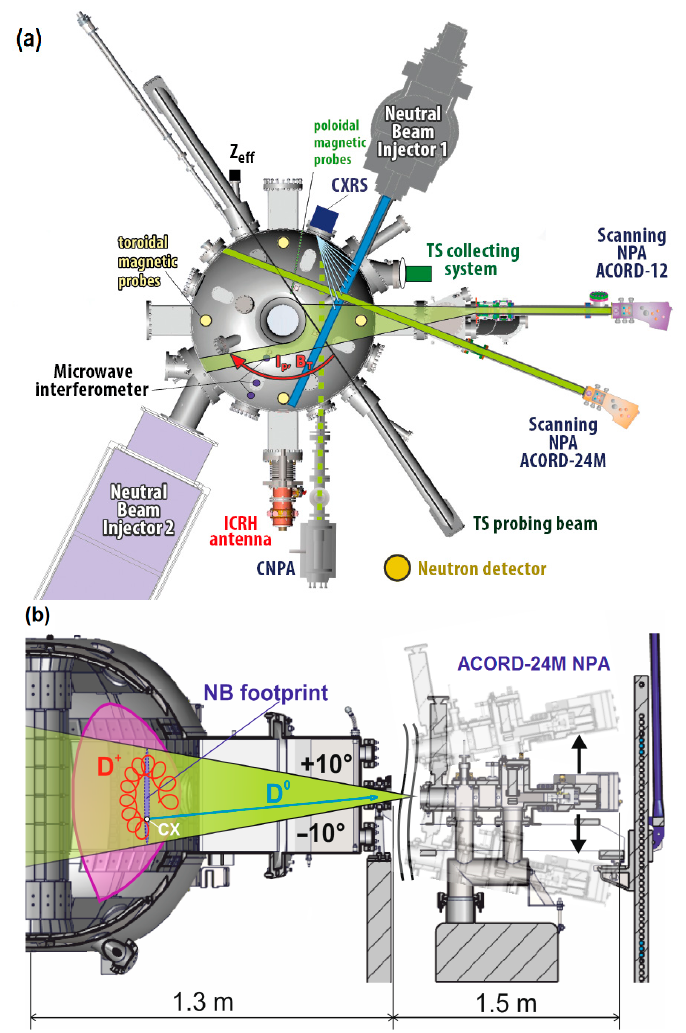
Figure 2. Experimental setup: ( a ) NPA arrangement at Globus-M/M2—top view. ( b ) Illustration of the vertical NPA scanning system. Figure ( b ) is taken from [30]. Reproduced with permission from IOP Publishing.